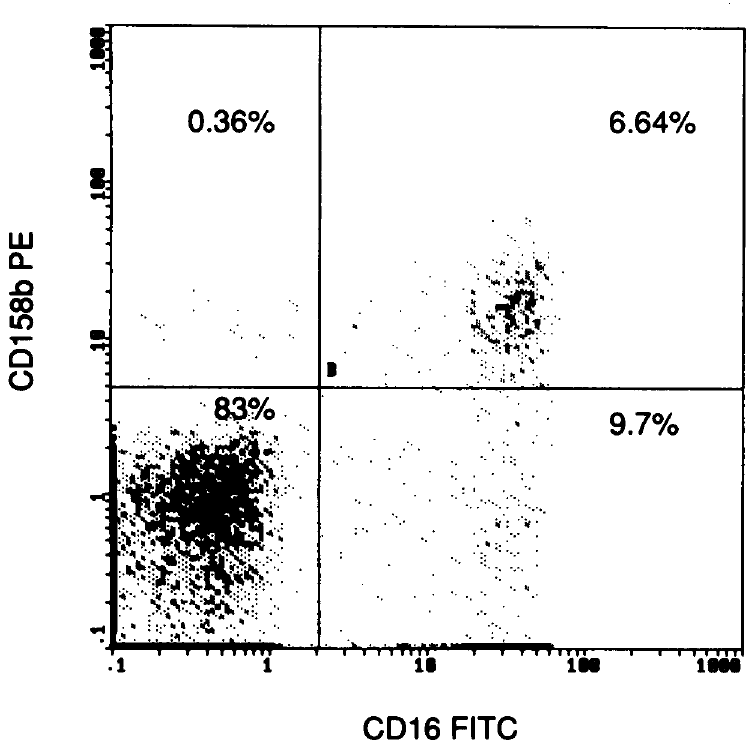
FIG. 1. Two-dimensional flow cytometric histogram of a representative sample. CD16-FITC is plotted versus CD158b-PE. Sixteen and three-tenths per cent of the lymphocytes were CD16-positive NK cells, of which 40.6% (6.64% of all lymphocytes) expressed